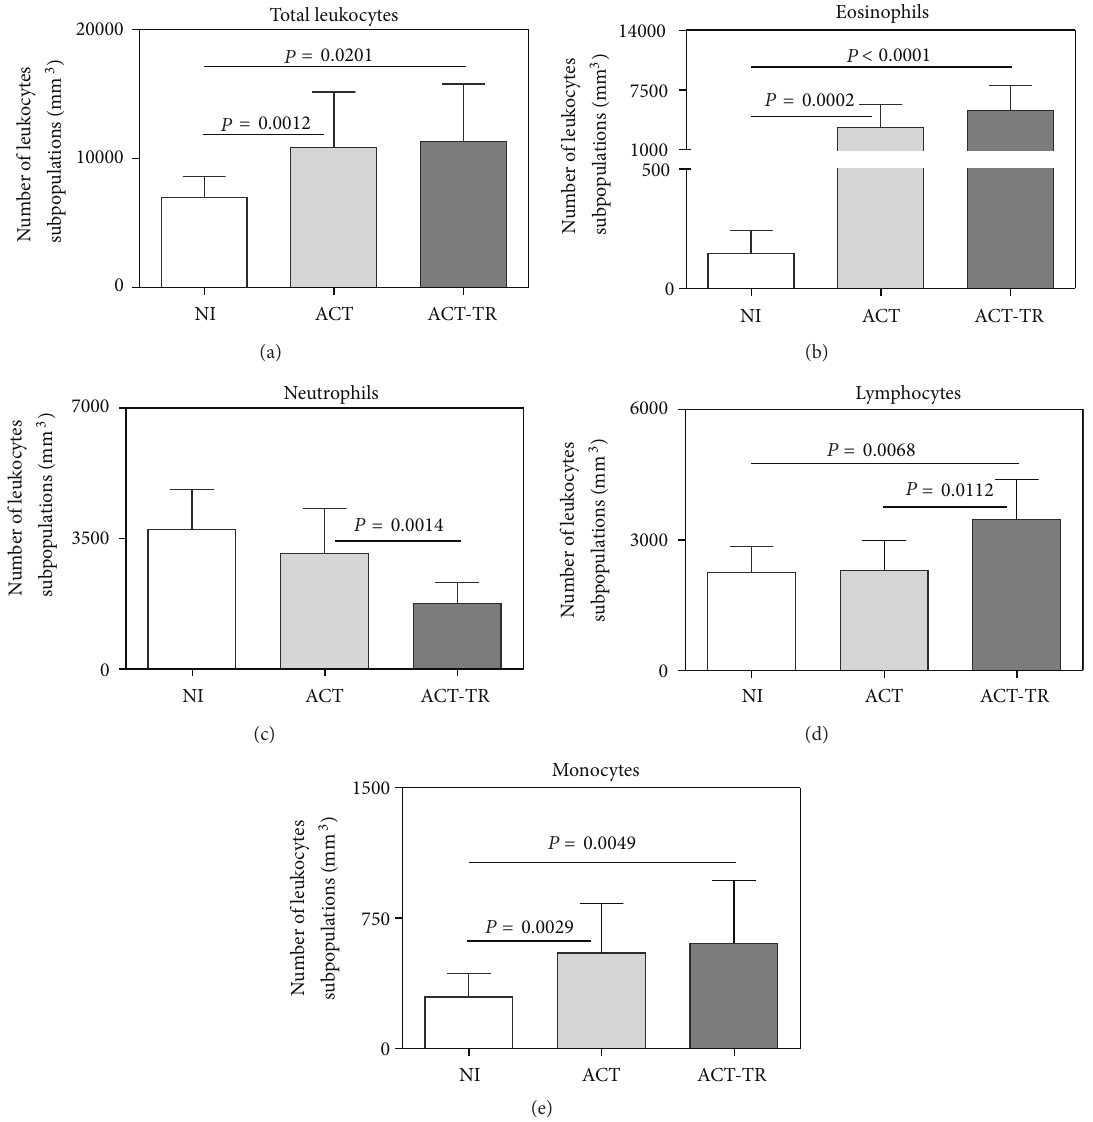
F 1: Analysis of hematological pro�le from patients with acute Schistosomiasis mansoni before (ACT, faint grey square = 21) and aer praziquantel treatment (ACT-TR, grey square = 07) and noninfected individuals (NI, white square = 19). e results are shown in bar-plot standard deviation. �tatistically signi�cant differences (connecting lines) observed format highlighting the mean counts of datasets/mm between groups NI, ACT, and ACT-TR were considered at 3 ± 𝑃𝑃 𝑃 𝑃𝑃𝑃𝑃